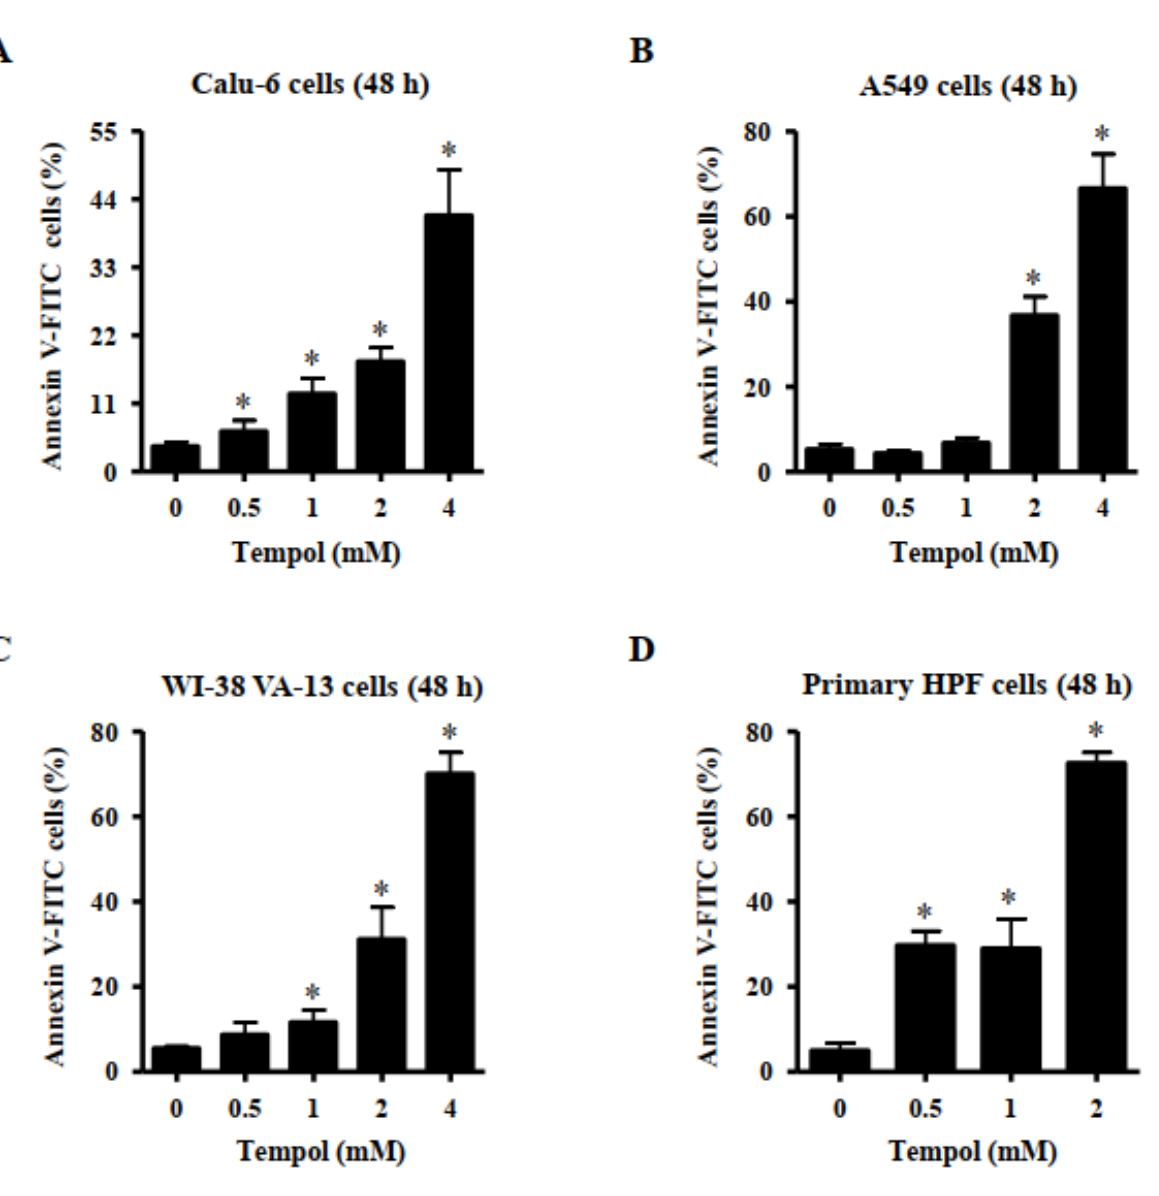
Figure 3. Effects of Tempol on annexin V-positive lung cancer and normal cells. Cells in exponential growth phase were incubated with Tempol at indicated concentrations for 48 h. Annexin V-FITC positive cells were evaluated with a FACStar flow cytometer. Graphs show the proportion of annexin V-positive Calu-6 cells ( A ), A549 cells ( B ), WI-38 VA-13 cells ( C ), and primary HPF cells ( D ). Student’s t -test was used. * p < 0.05 compared to Tempol-untreated control cells.